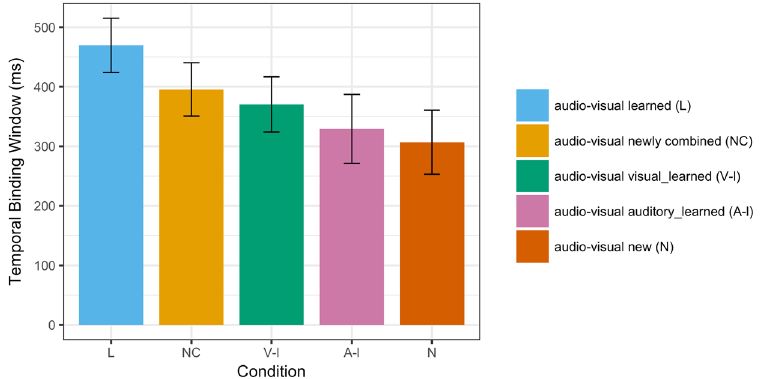
Figure 2. Mean size of the temporal binding window (TBW) for audio-visual learned (L), audio-visual newly combined (NC), audio-visual visual_learned (V-l), audio-visual auditory_learned (A-l) and audio-visual new (N) stimuli. Error bars denote standard errors of the